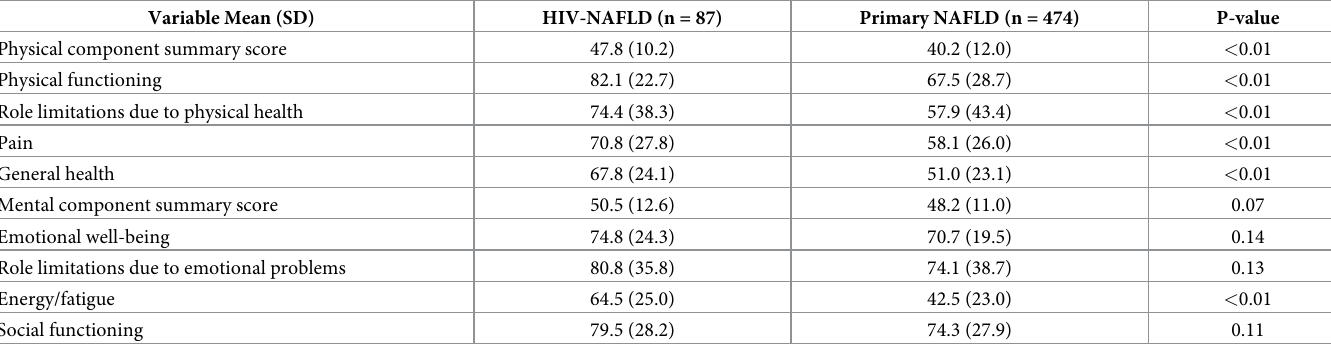
Table 4. Comparison of health-related quality of life in HIV-NAFLD and primary